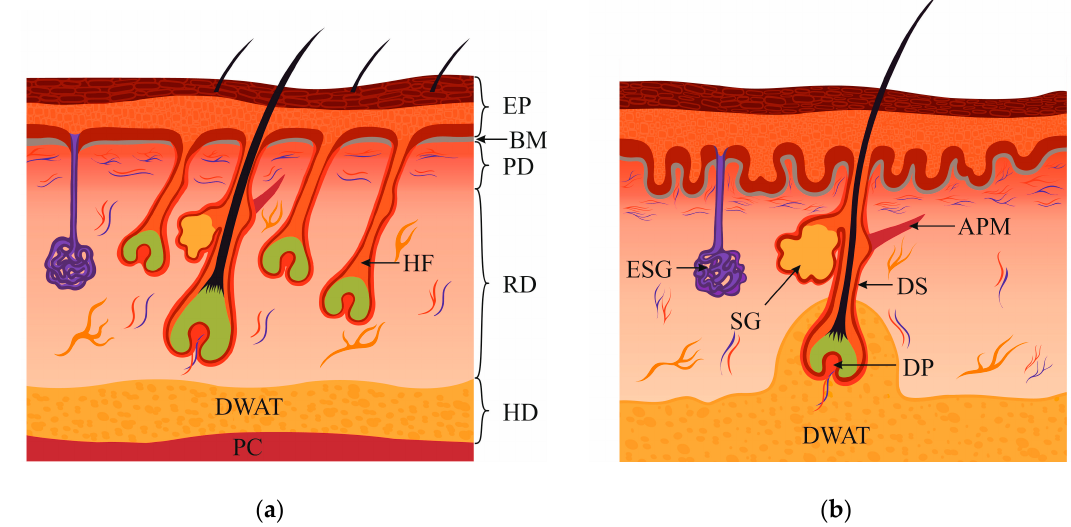
Figure 1. Skin structure: ( a ) murine skin structure. The murine skin has a high density of HFs including tylotrich and non-tylotrich HFs. The mouse back skin has four types including guard (tylotrich) and awl, auchene, zigzag HFs (non-tylotrich). The panniculus carnosus is under the hypoderm. ( b ) Human skin structure. Human skin structure differs from that of the murine. Epidermis is thicker and forms ingrowths called rete ridges. Accordingly, the papillary dermis forms dermal papillae. Two types of HFs are distinguished: guard HFs and vellus HFs. HFs density in the skin is less as compared to mouse one. DWAT is cone shaped. APM — arrector pili muscle;